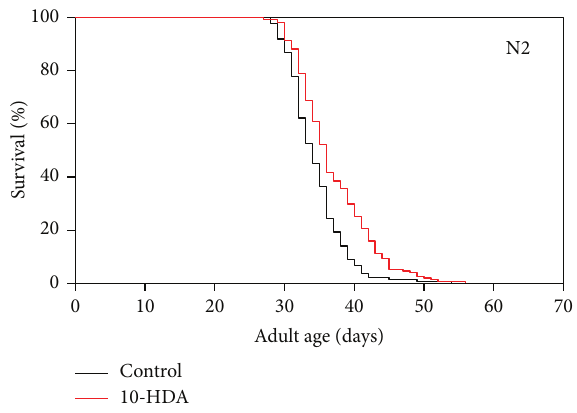
Figure 1: The effect of 10-HDA on the lifespan of N2 wild type C. elegans . The curves shown in Figures 1, 2, 3, and 5 represent pooled data from three to four experiments (Table